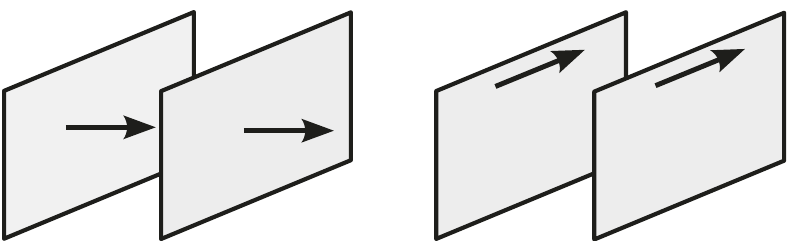
Fig. 3 Longitudinal vs. transverse response. A current fl owing in response to a perturbing force may originate through longitudinal or transverse actions, corresponding to pushing and shearing, respectively. A super fl uid responds to longitudinal but not transverse perturbations 3 – 6,9,15 –